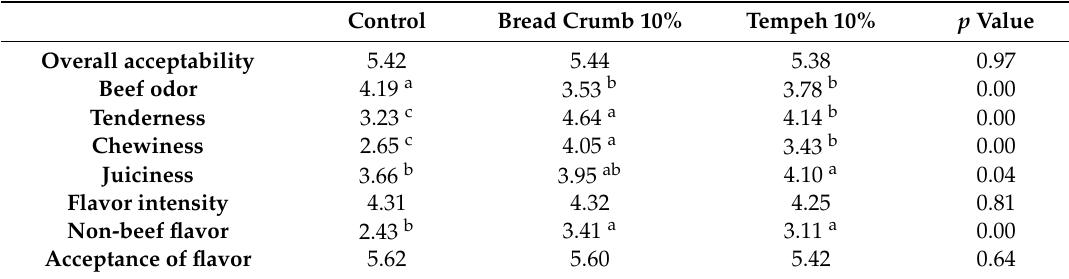
Table 5. Mean scores for sensory attributes of five beef patties substituted by tempeh at di ff erent levels in the pilot sensory study. The patties were evaluated by a small number of panelists ( n = 14). a–c Within each row, means that do not share the same letters are significantly di ff erent ( p <